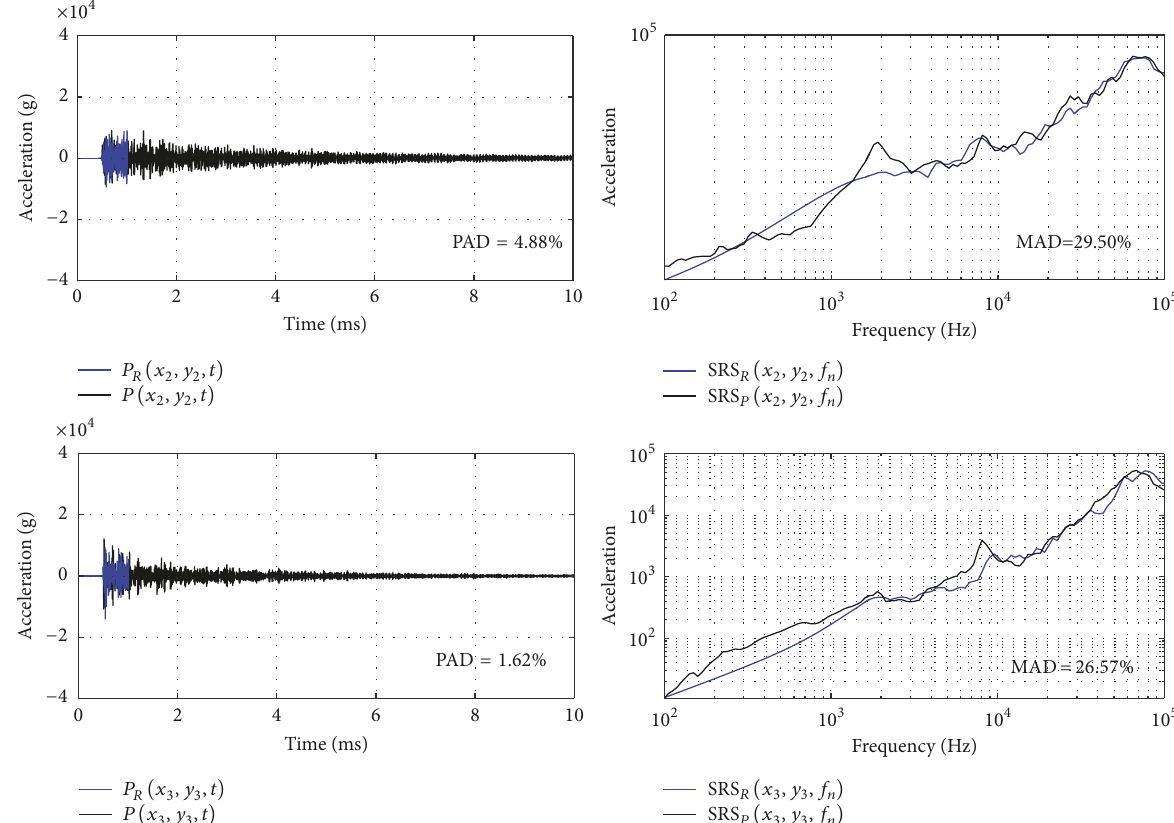
Figure 23: Reconstruction results of pyroshock on the disk type specimen at the training points.